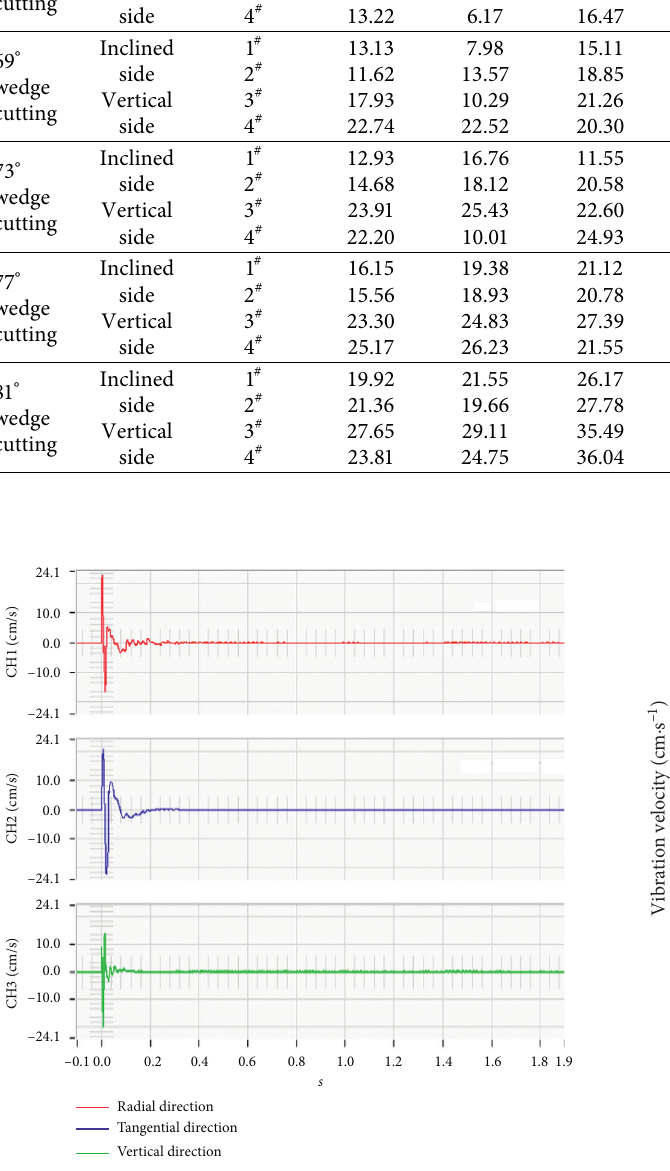
Figure 22: Model waveform of wedge cutting blasting.